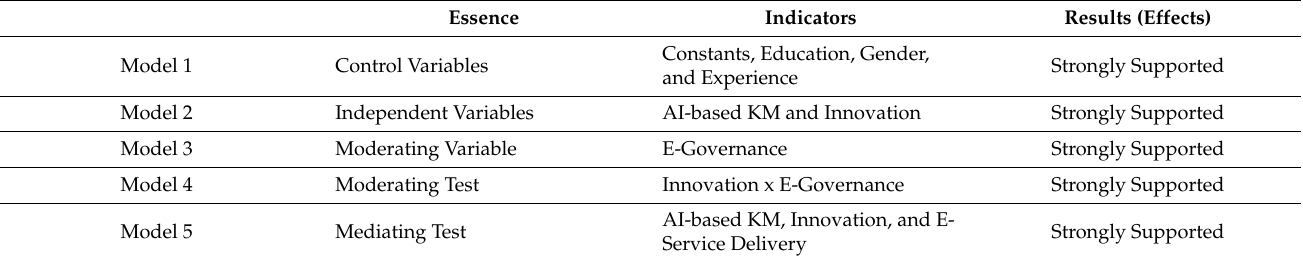
Table 5. Characteristics of the evaluation models of artificial intelligence-based technological-oriented knowledge management, innovation, and e-service delivery in smart cities.